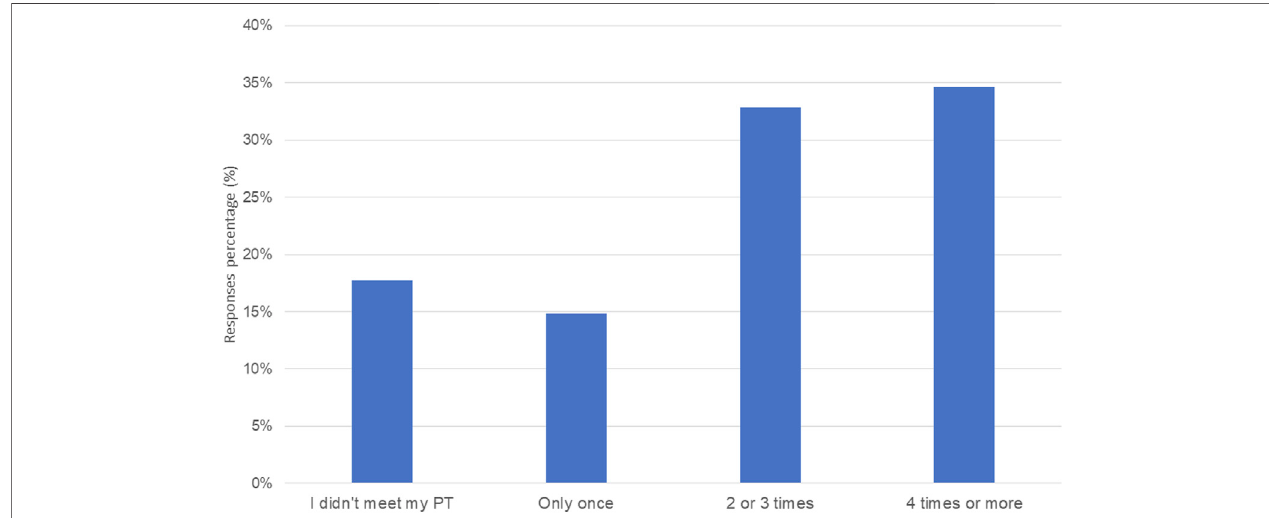
FIGURE 1 | Number of times students met with their Personal Tutors during the academic year 2019 –